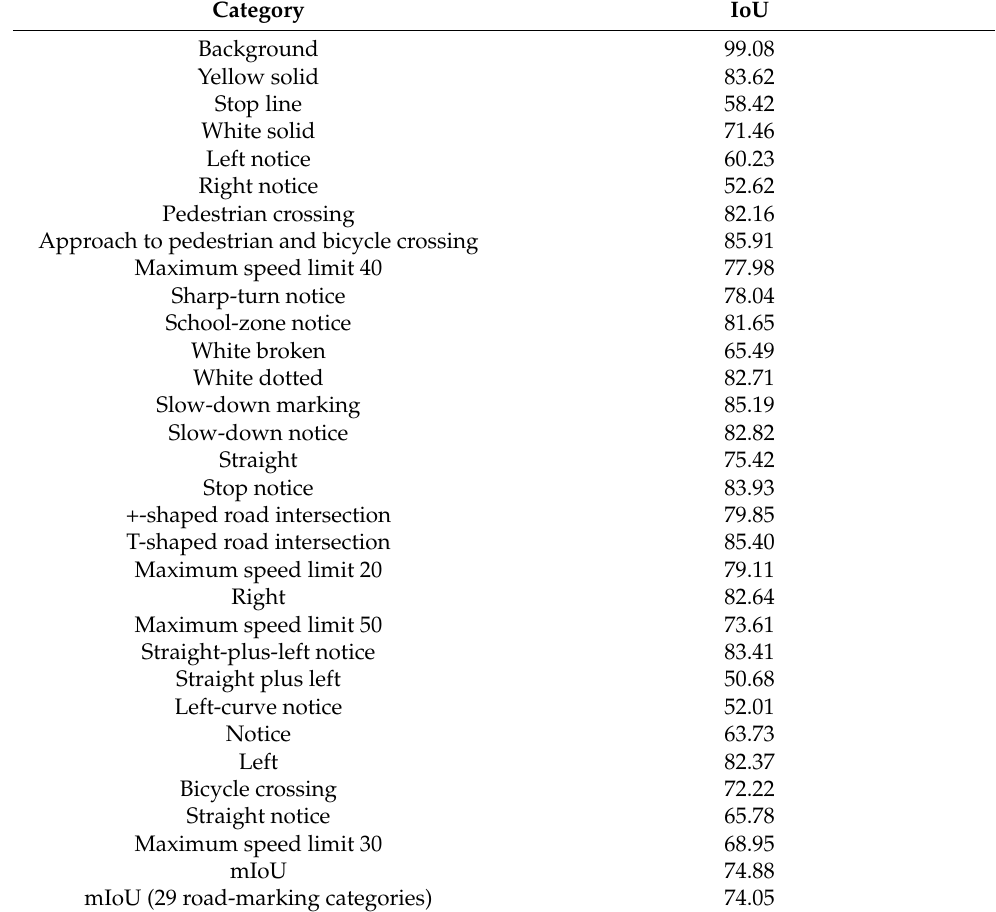
Table 6. IoU of each category obtained by Model 2 with scales = { 0.5,1.0,2.0 }